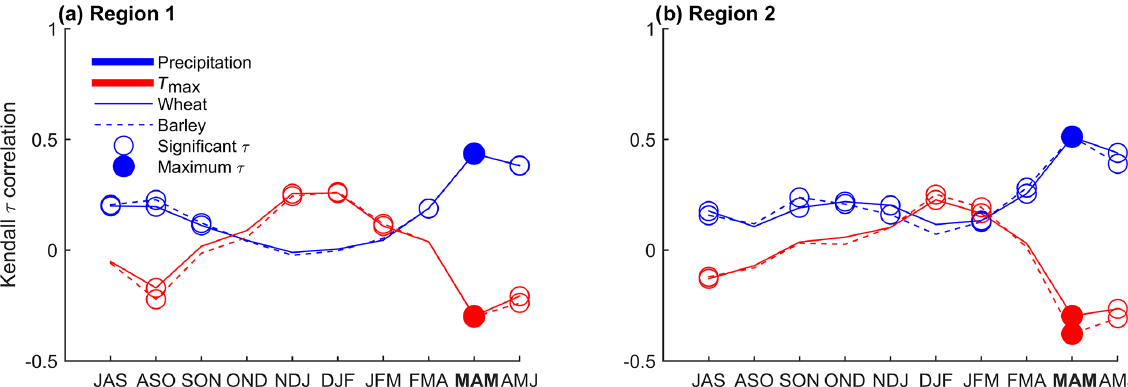
Figure 2. Kendall correlation τ between 3-monthly means of maximum temperature ( T max , red) and precipitation (blue) with wheat (solid lines) and barley (dashed lines) yield anomalies. Correlations were computed during the crop-growing period (September to June) over 1986–2016 for Region 1 (a) and 2 ( b ; Fig. 1). The letters on the x axis denote the 3-month averaging periods. Circles indicate statistically significant correlations at α = 0 . 05. The strongest correlation (positive or negative) is denoted by filled circles ( P MAM and T max